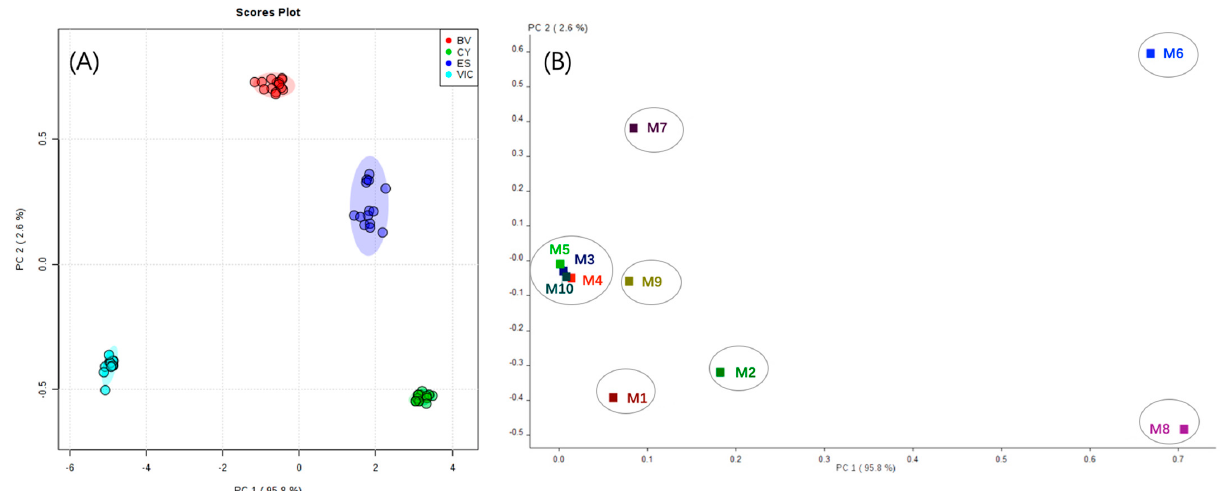
Figure 1. Principal component analysis of passion fruit wine fermented by commercial yeast strain ES488 (ES), BV818 (BV), VIC (VI) and CY3079 (CY). ( A ) The scores plot of passion fruit wine